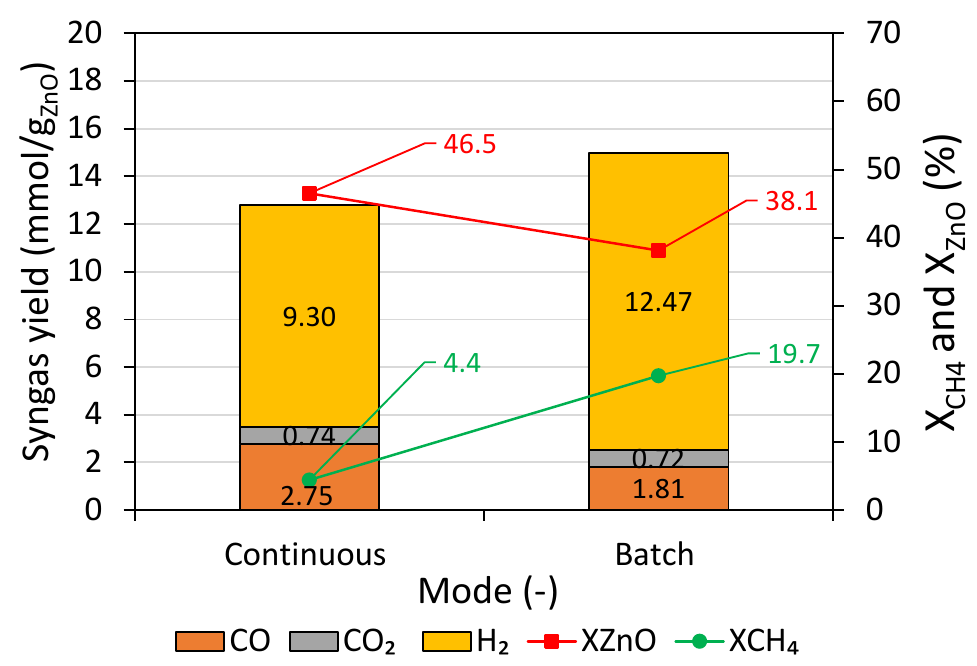
Figure 7. Syngas yield, methane conversion (X CH4 ), and net ZnO conversion (X ZnO ) in batch and continuous modes. Source: author.